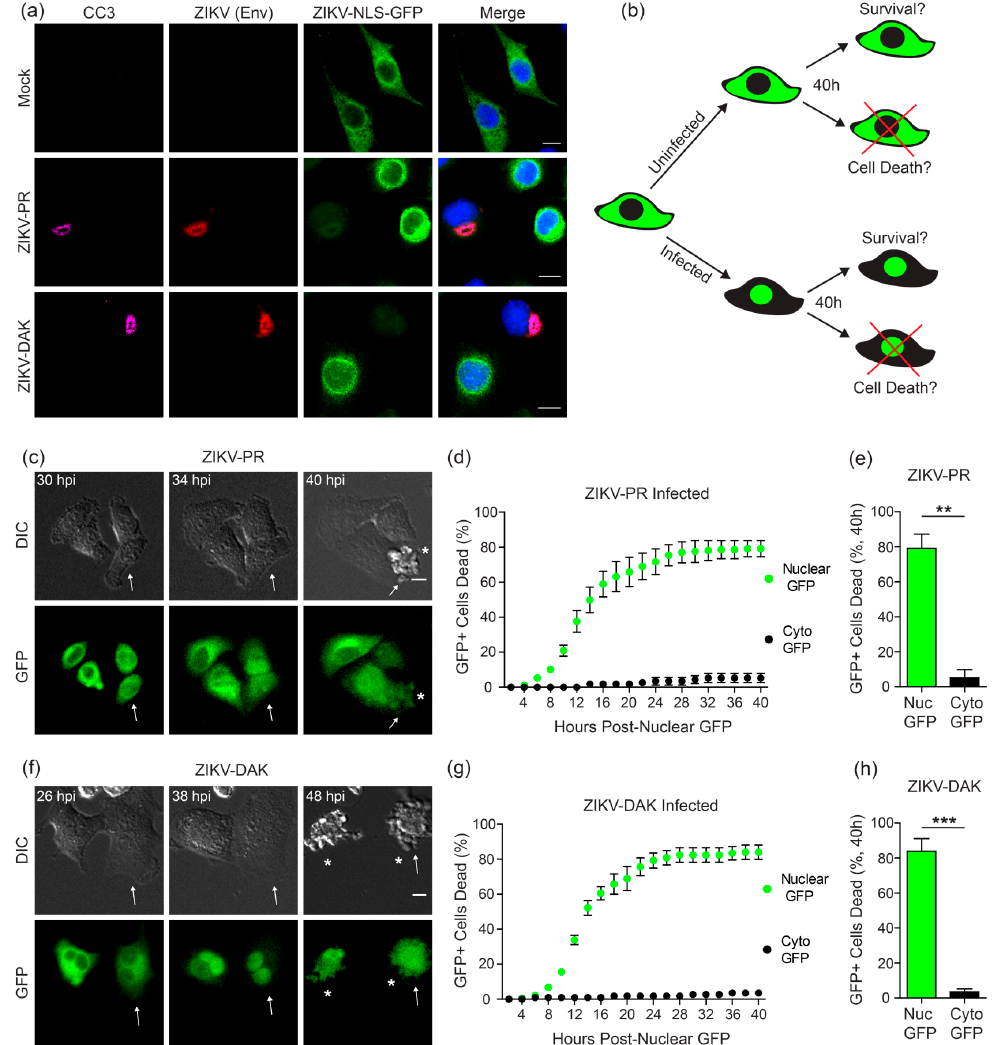
Figure 5. ZIKV induces cell death in virus-positive cells. ( a ) Confocal micrographs of A549 cells stably expressing the ZIKV-NLS-GFP reporter (green) that were infected with ZIKV-PR or ZIKV-DAK (MOI 10), or mock for 48 h and then immunostained for ZIKV (anti-Envelope (Env); red) and cleaved Caspase-3 (CC3; magenta). Nuclei were stained with DAPI (blue). Scale bar, 10 μ m. ( b ) Schematic of the live cell imaging analysis performed to quantify cell death in ZIKV-uninfected and infected cells. ( c , f ) Fluorescence microscopy shows sequential images of the same field of A549 cells stably expressing ZIKV-NLS-GFP after infection (MOI 10) with ZIKV-PR ( c ) or ZIKV-DAK ( f ) at the indicated hours post infection (hpi) between corresponding DIC (top) and GFP (bottom) images. Arrows mark cells of interest and asterisks denote cells that have died. Scale bar, 10 μ m. ( d , e , g , h ) Quantification of the time of death of cells in ZIKV-infected cultures from live cell imaging experiments (represented by Movies S2 and S3). Individual fluorescent cells were tracked and identified as positive for ZIKV by determining the incidence and time point of nuclear GFP translocation. The time point of cell death was determined by assessing cellular morphological changes as seen in the DIC channel, and the time between GFP translocation and cell death was calculated. For uninfected cells that did not undergo nuclear translocation, the time between apoptosis and the first nuclear translocation event in the entire field was calculated and plotted. Values represent the mean ± SEM ( n = 10 fields) from three independent experiments, with 10 cells counted per field. Cell death in infected (Nuc GFP) and uninfected (Cyto GFP) cells is directly compared at 40 h post-nuclear GFP translocation in ( e , h ). Asterisks denote significance; ** p = 0.0002 ( e ) and *** p < 0.0001 ( h ), as determined by an unpaired t -test.